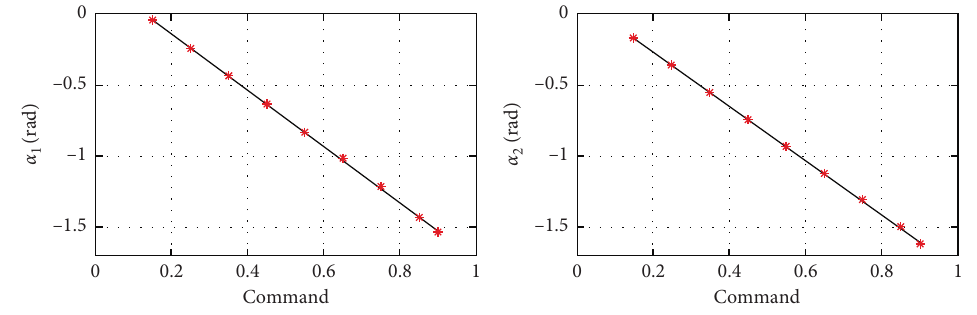
Figure 7: Fitting results of the tilting